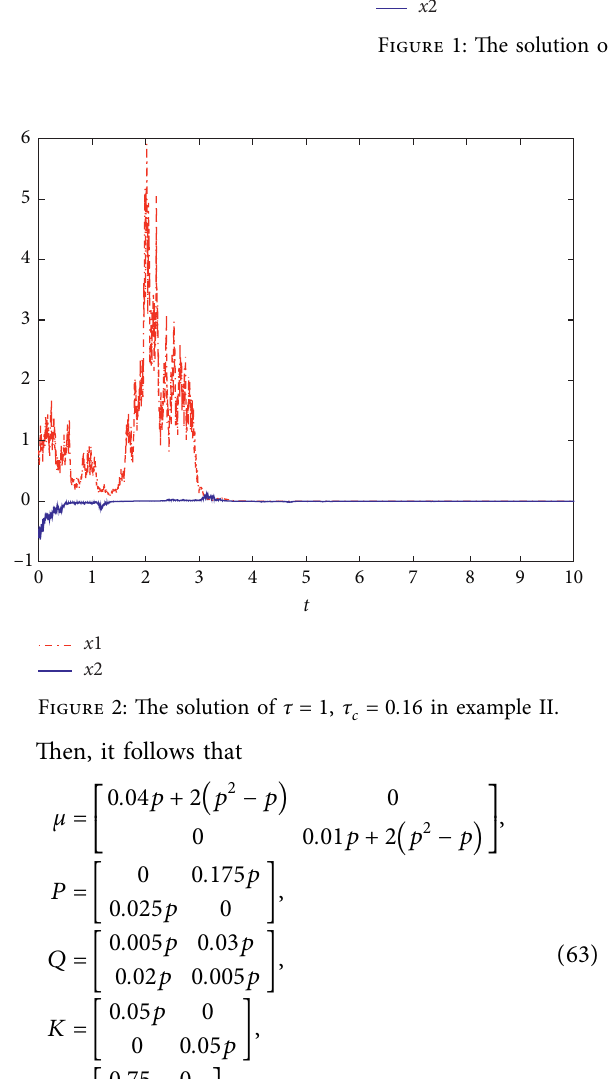
� 6 in example I. c